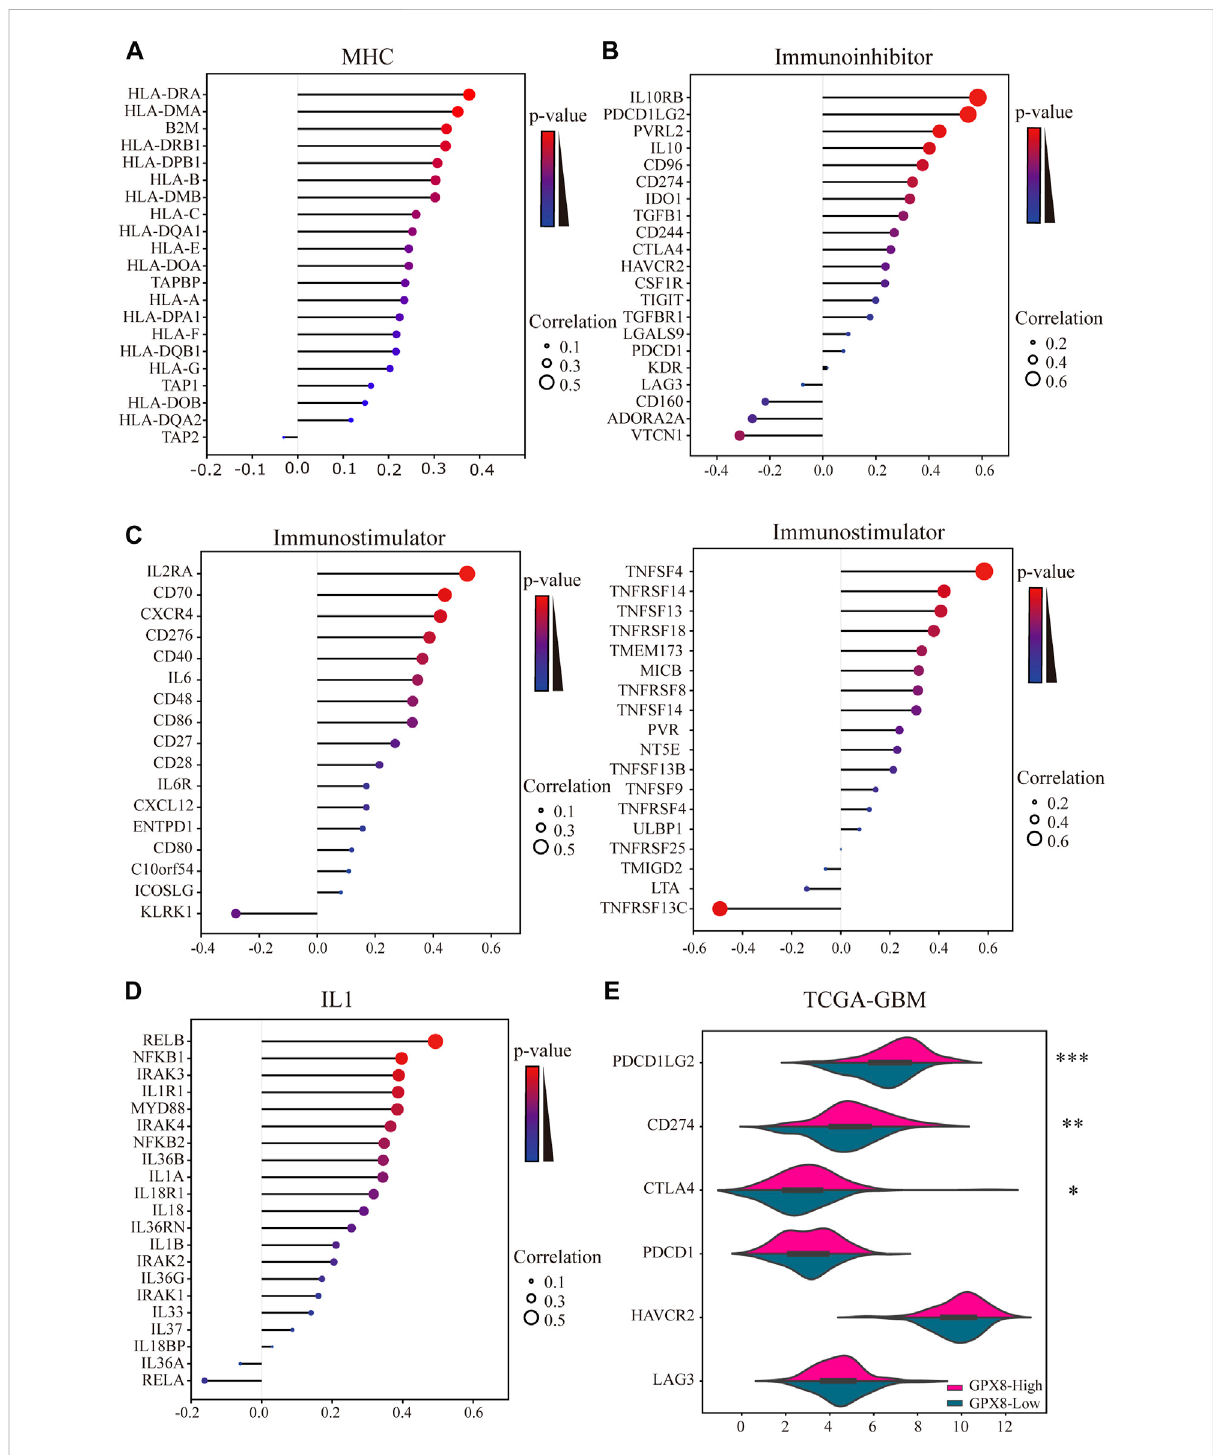
FIGURE 7 Results of analysis between the expression of GPX8 and immune markers. Co-expression of GPX8 with (A) MHC molecules, (B) immunoinhibitors, (C) immunostimulators, and (D) IL1 pathway – related molecules based on TISIDB and cBioPortal databases. (E) Different expression of immune checkpoints in GBM with high or low expression of GPX8. * p < 0.05, ** p < 0.01, and *** p <